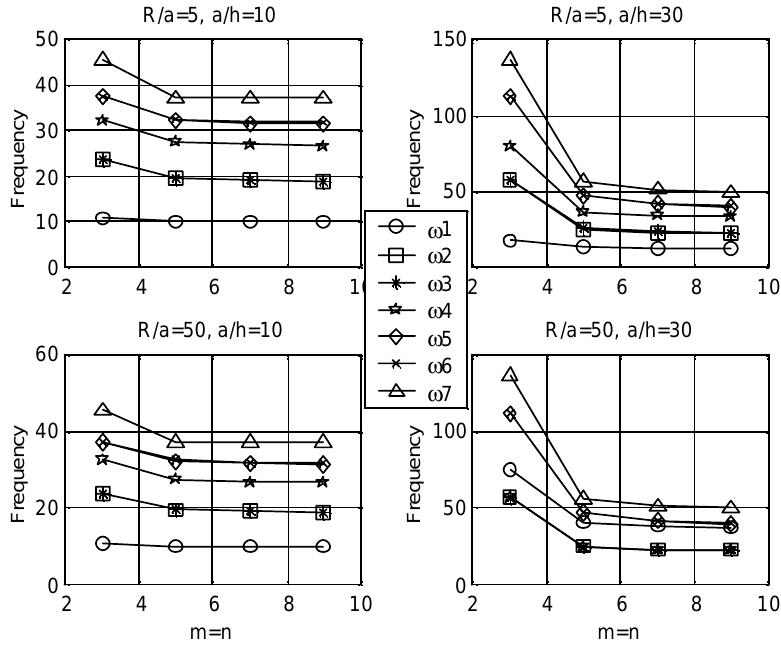
Fig. 2. Normalized natural frequencies for isotropic cylindrical panel with b/a =